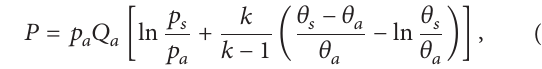
Figure 4: Configuration of experimental apparatus.